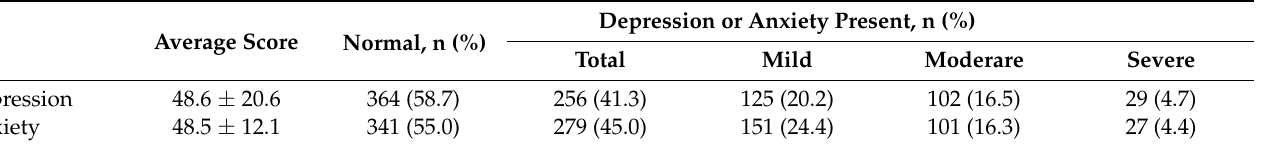
Table 2. The prevalence of symptoms of depression and anxiety among the DKD patients (n =